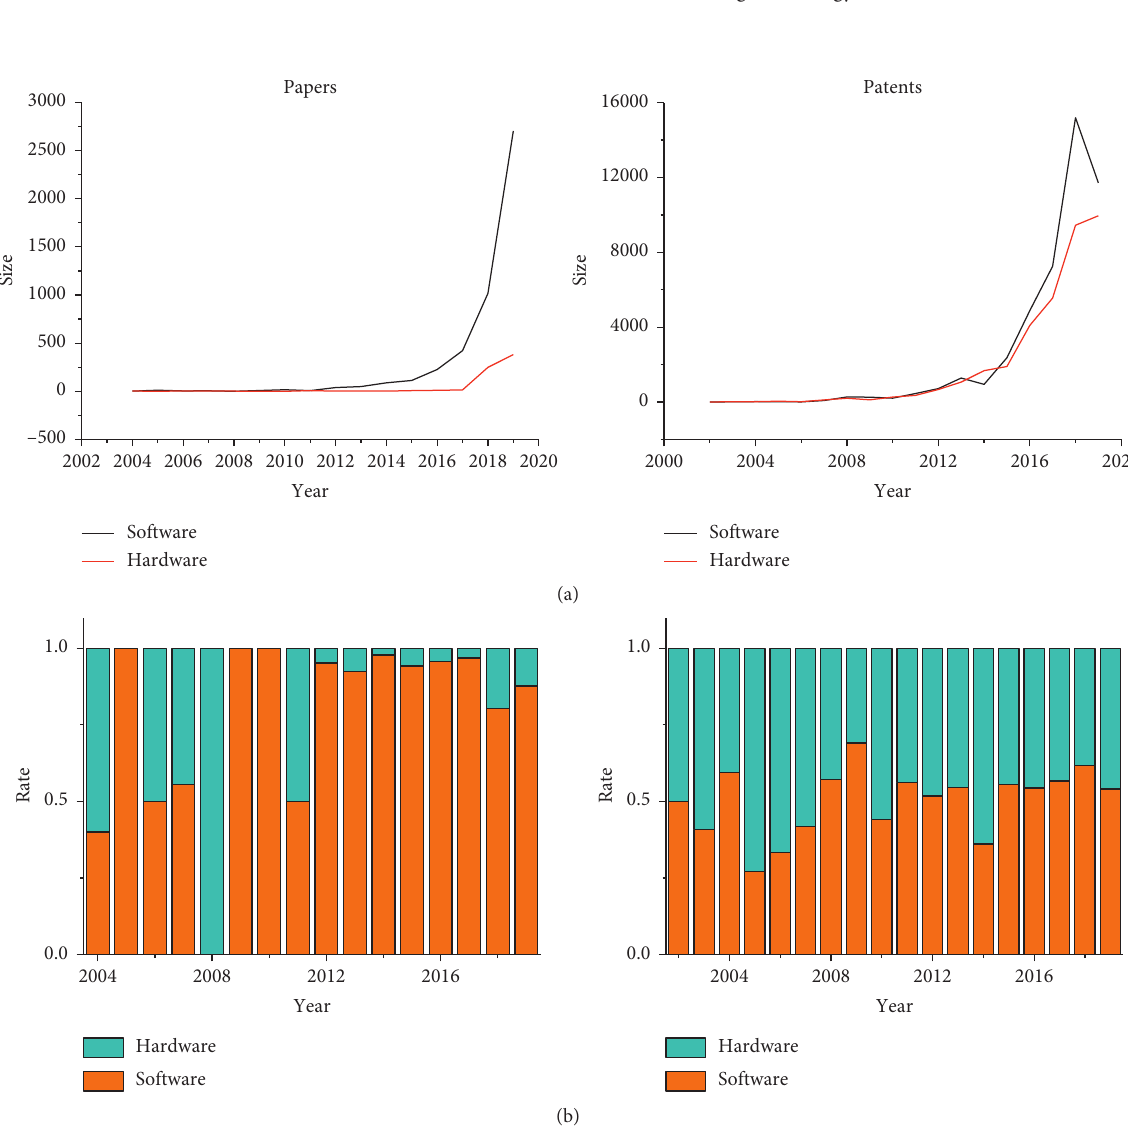
Figure 7: The hierarchical structure of self-driving